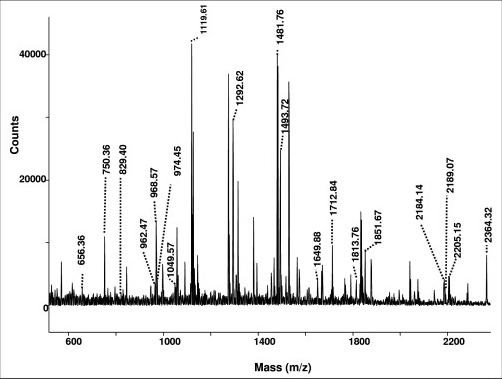
The mass spectrum showing the tryptic fragments of the 80 kD band analyzed by MALDI-TOF-MS that matched to sequences from catalase. The Coomassie stained band migrating at 80 kD was excised and subjected to in-gel tryptic digestion and MALDI-TOF-MS. The mass of each individual peak was used to perform a Mascot Search, which identified human catalase as the primary candidate antigen (38% match). Of the 59 mass values searched, 19 of them matched to sequences obtained from catalase. The probability based Mowse score obtained for the Mascot search analysis was 100, where a score of 64 is significant (p < 0.05). X-axis gives the mass to charge ratio (m/z) and Y-axis gives the intensity of the peaks in counts.